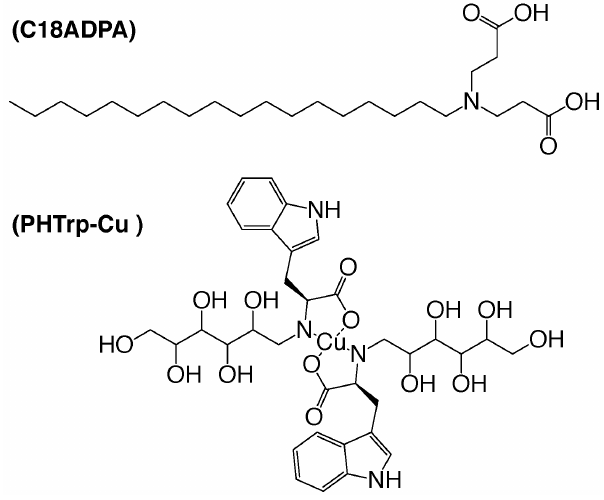
Figure 1. The chemical structures of C18ADPA and